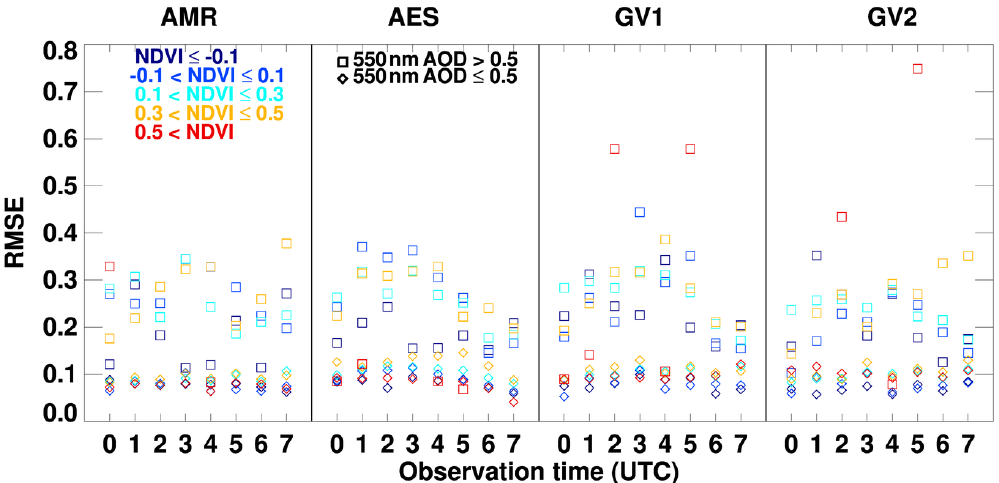
Figure 1. RMSE according to NDVI (color), observation time, and satellite AODs (squares and diamonds represent RMSE for AOD greater than 0.5 and less than or equal to 0.5, respectively) during April 2018 to March 2019 excluding the EMeRGe campaign. Colors represent different NDVI bins.